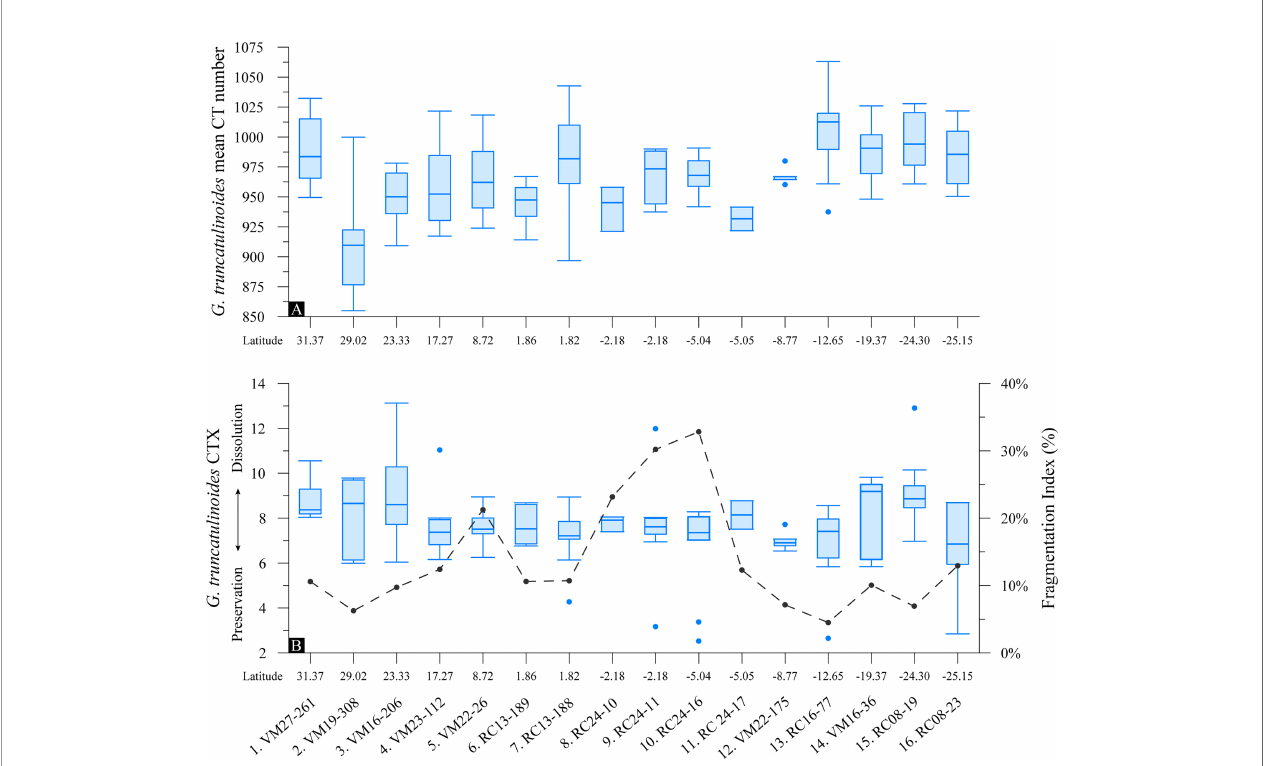
FIGURE 7 | Box-and-whisker plots of foraminifera test (A) mean CT number indication test relative densities and (B) CTX dissolution index of the specimens with latitude for G. truncatulinoides (n = 144) superimposed with the planktonic foraminifera Fragmentation Index. Boxes extend from the lower to upper quartile values of the data, with a line at the median. Whiskers indicate 1.5 times the inter-quartile distance. Dots are